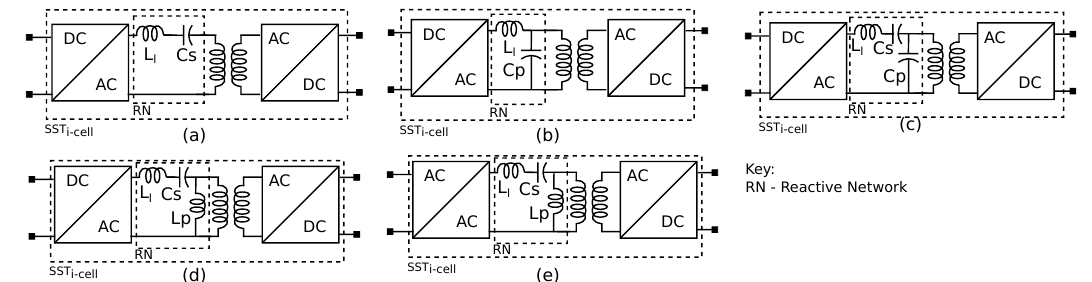
Figure 15. Coupled control: isolation stage based on resonance stage [38,68,79]: ( a ) isolated DC/DC stage based on series resonance circuit, ( b ) isolated DC/DC stage based on parallel resonance circuit, ( c ) isolated DC/DC stage based on hybrid LLC resonance circuit, ( d ) isolated DC/DC stage based on hybrid LCC resonance circuit, ( e ) isolated AC/DC stage based on LLC